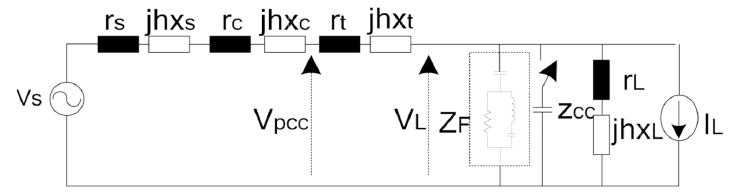
Figure 3. Single-phase equivalent circuit